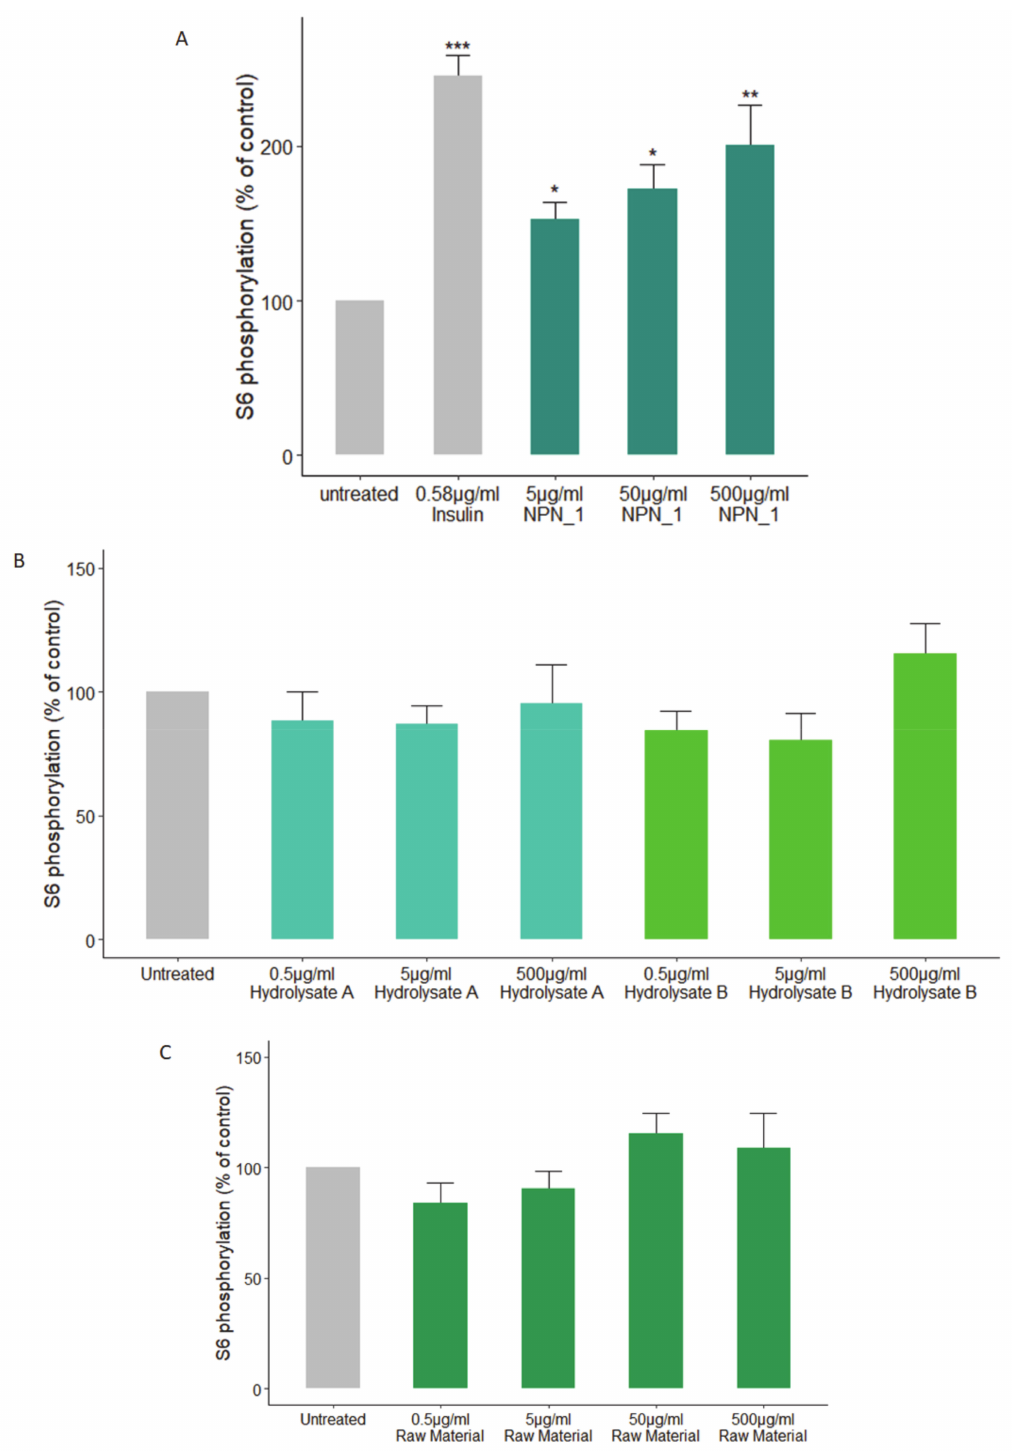
Figure 1. E ff ect of the natural peptide network_1 (NPN_1) treatment on S6 phosphorylation. C2C12 cells were treated with ( a ) NPN_1 (5–500 µ g / mL), ( b ) hydrolysate A, hydrolysate B or ( c ) raw material (5–500 µ g / mL) for 30 min following a starvation protocol and compared to untreated cells (control) and expressed as the % of controls (one-way ANOVA analysis; * p < 0.05; ** p < 0.01; *** p < 0.001; at least three independent